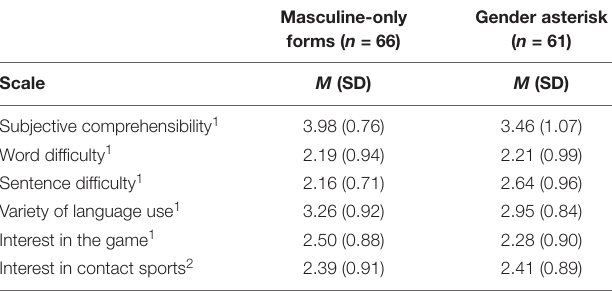
TABLE 4 | Descriptive statistics for the two texts in Experiment